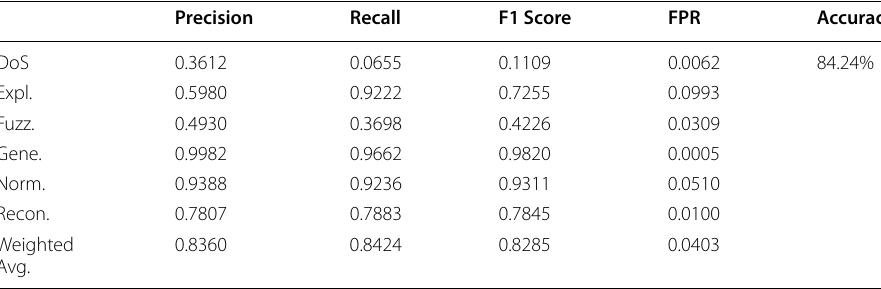
Fig. 11 Confusion matrix of our results